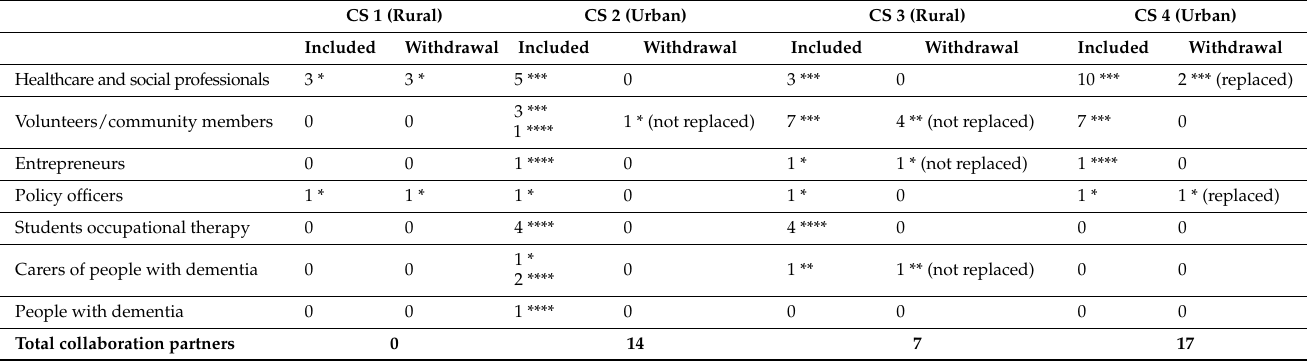
Table 1. Overview of collaboration partners for DFIs in the four